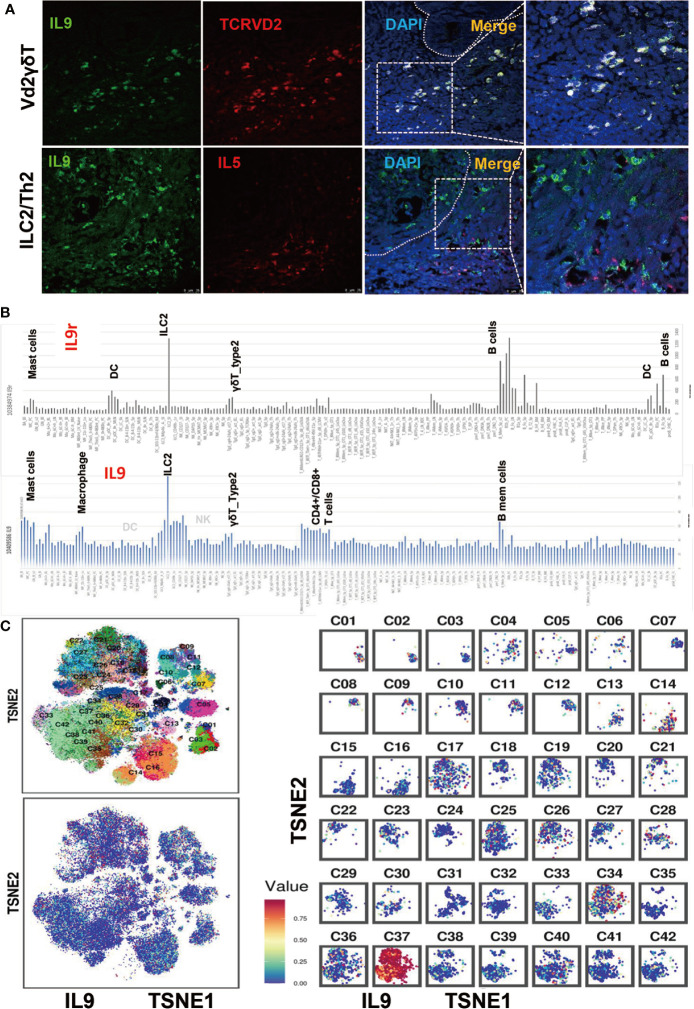
The Component of IL-9 Producing Immune Cells in EC. (A) Immunofluorescence staining of IL9 + Vδ2 γδT cells and IL9 + ILC2 cells in EECs. (B) This panel showed the gene skyline presenting the expression profiles of IL9 and IL9R in the majority of immune cell types through microarray and ULI RNA-seq data. IL9R was found up-regulated in B cells, mast cells, dendritic cells, Vδ2 + γδT cells, and ILC2, with ILC2 expressing a significantly higher level of IL9R compared to other immune cells. Similarly, it’s ligand IL9 was also enriched in ILC2, Vδ2 + γδT cells, memory B cells, and CD4+/CD8+ T cells. (C) The tSNE map generated by CyTOF, the IL9 was enriched in cluster 37 (TH9 cells) , cluster 9 (Vδ2 + γδT cells), cluster 14 (NK cells), cluster 8 (macrophage), cluster 1 (MDSC), and ILC2s. C1–42 means Cluster1–42.